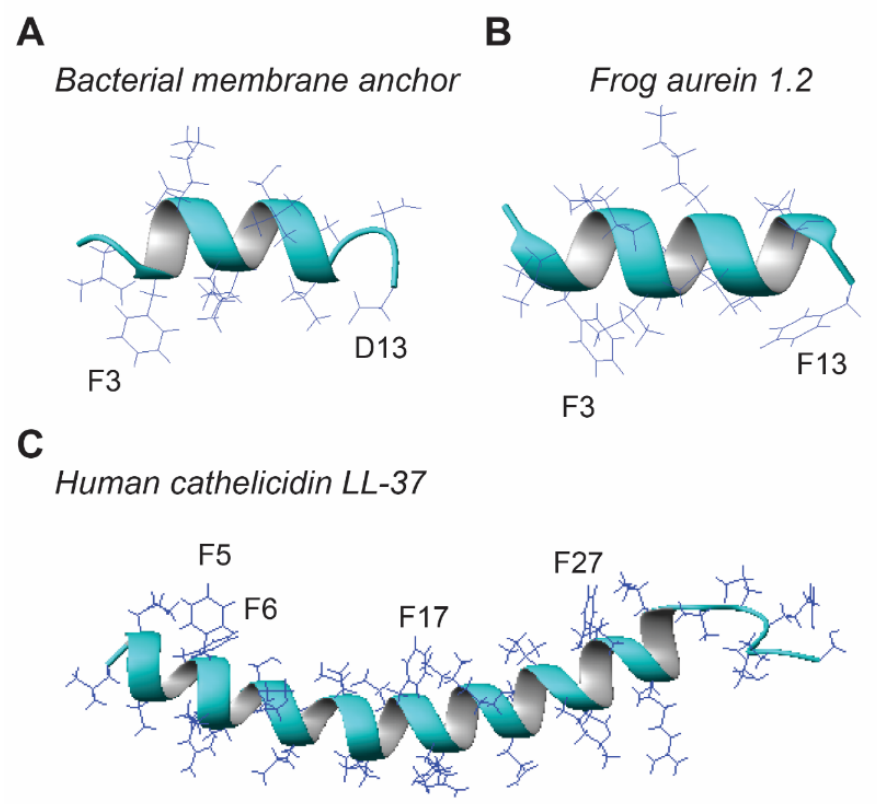
Figure 7. Three-dimensional structures of ( A ) E. coli membrane anchor; ( B ) amphibian aurein 1.2; and ( C ) human cathelicidin LL-37 determined by multidimensional NMR spectroscopy [65,136,141]. The importance of the aromatic rings for membrane targeting is indicated by an intermolecular nuclear Overhauser enhancement (NOE) between the aromatic protons and bacterial anionic phosphatidylglycerols (PGs).